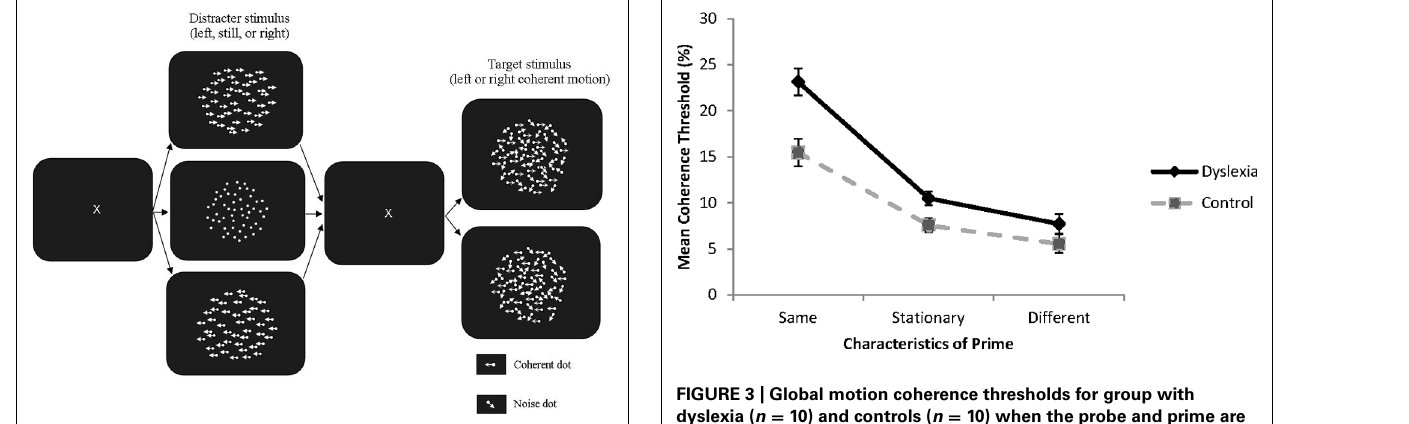
FIGURE 2 | Motion SegmentationTask used in Experiment 2. The fully coherent prime was presented in either the same or opposite direction to the partially coherent test.The stationary prime was used as a control condition.The blank stimulus between the prime and test was presented for 96 ms and the test stimulus was presented for 160 ms (10 animation frames).